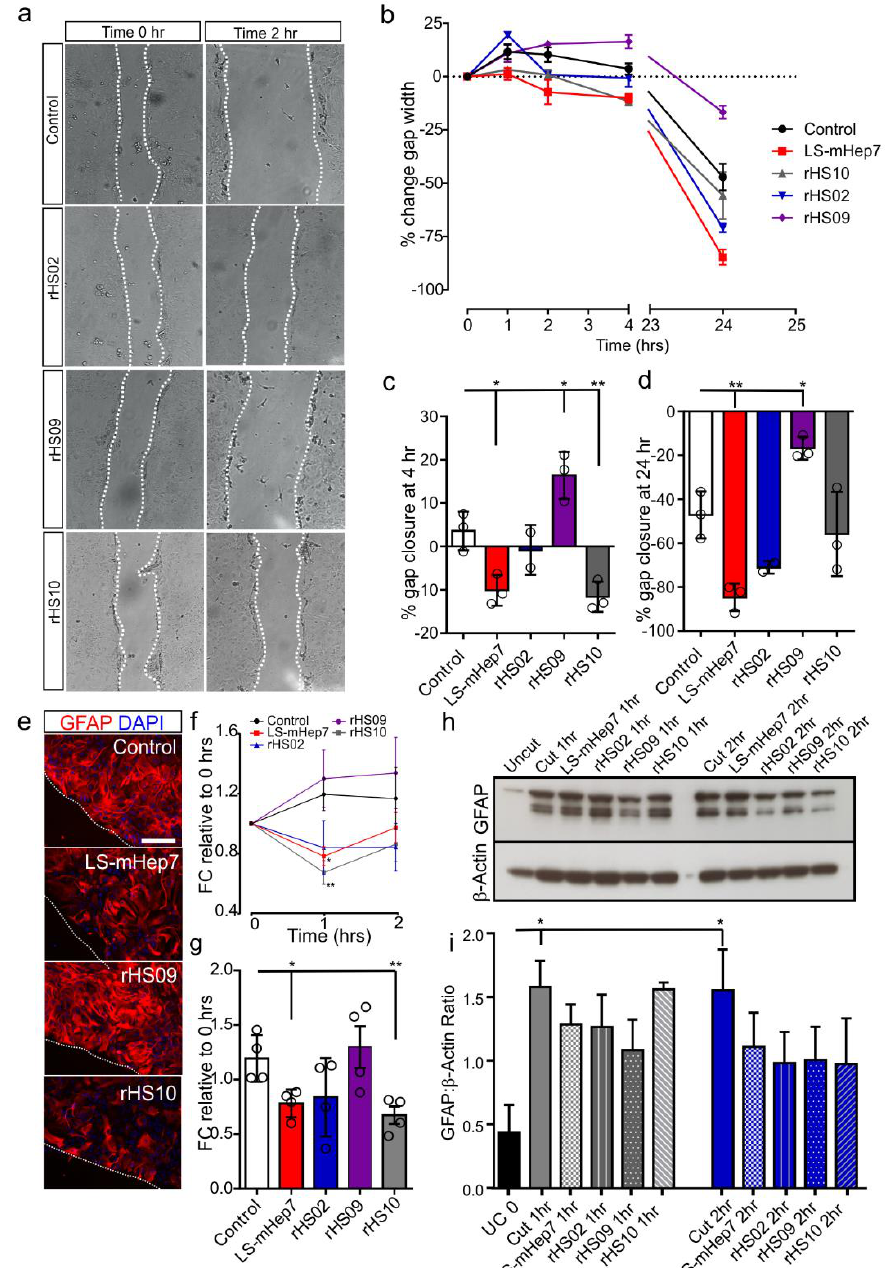
Figure 4. Effect of LS-mHep7, rHS02, rHS09 and rHS10 on astrocyte reactivity after injury. Mono- layers of astrocytes were injured by scratching using a pipette tip down the center. Immediately after injury, cells were treated with rHS02, rHS09, rHS10 or LS-mHep7 at 100 ng/mL) or media as a control. ( a ) Representative phase images of scratch astrocytes immediately after injury (Time 0 h) or 2 h after injury (Time 2 h) in control, rHS02, rHS09 or rHS10 treatment ( b ) Measurements of scratch width were made on phase images at 1, 2, 4 and 24 h following the same injury site over time and gap width is presented as a % of the original width at time 0. ( c ) LS-mHep7 and rHS10 promoted a faster closure of gap width at the 4 h timepoint compared to control astrocytes, whereas rHS09 caused the gap to widen ( d ) LS-mHep7 promoted a faster recovery of astrocyte gap closure at 24 h compared to untreated astrocytes, whereas rHS09 significantly prevented closure. ( e ) Representa- tive immunohistochemical images of GFAP immunoreactivity immediately adjacent to the lesion in control cut cultures and those treated with LS-mHep7, rHS09 or rHS10, 1 h post-injury. Dashed line indicates injury edge. GFAP stains astrocytes red, DAPI stain nuclei in blue. Scale bar represents 50 μm. ( f ) Quantification of GFAP immunohistochemistry using Image J thresholding of images